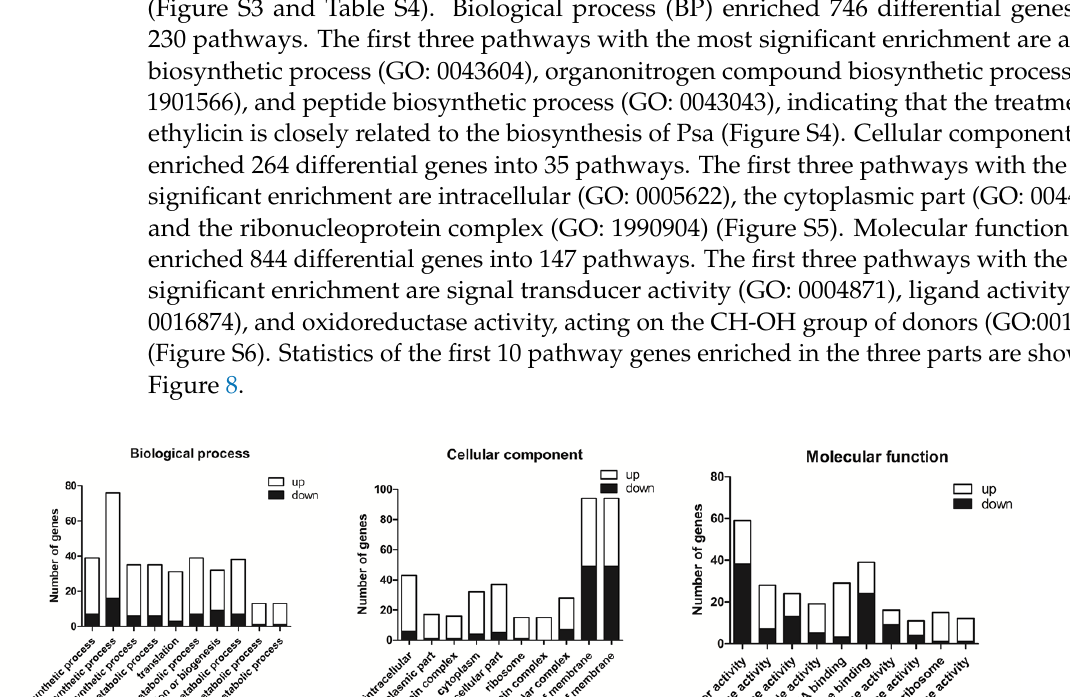
Figure 8. Biological process (BP), cellular component (CC), and molecular function (MF) enrichment of the number of genes in the top 10 pathways.